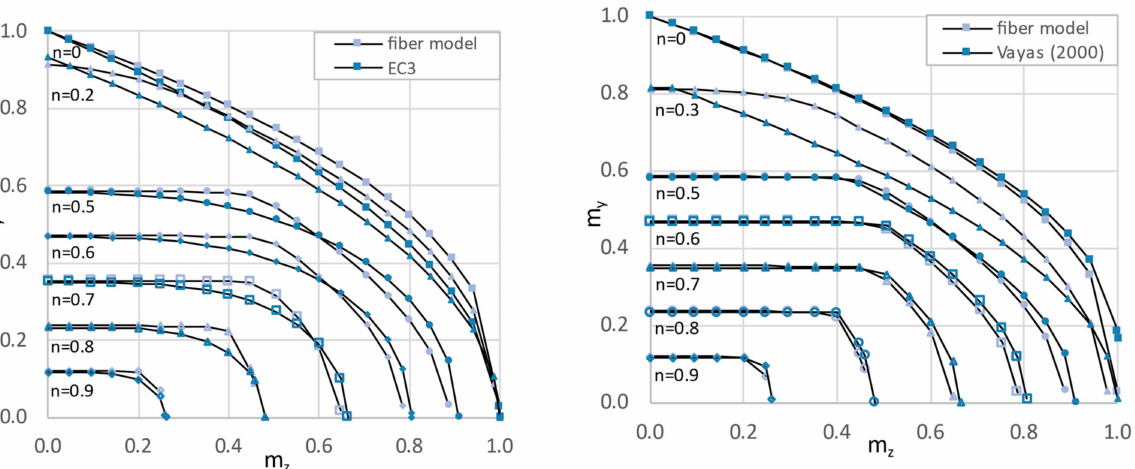
Figure 1. Comparison of interaction resistance diagrams n + m y + m z of numerical analysis (fiber model) and analytic formulae EC3 [1], Vayas (2000) [26] for a HEB 450 section.